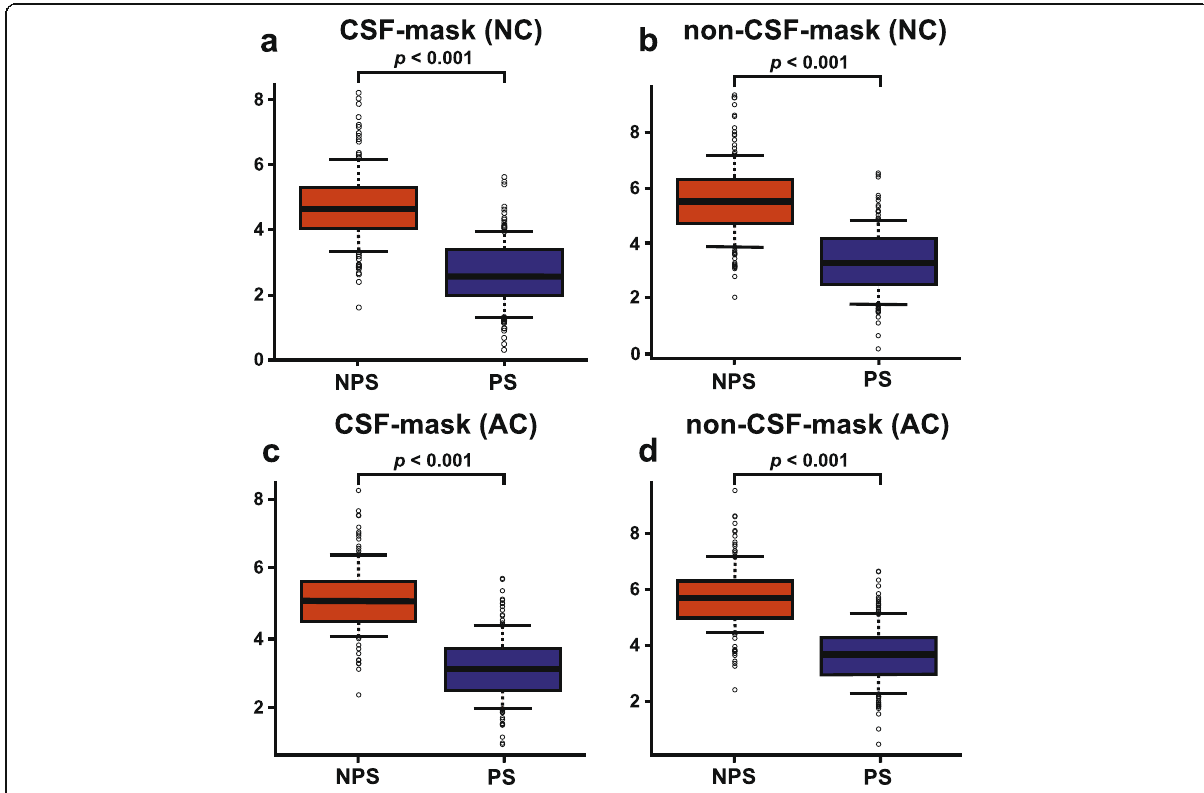
Fig. 3 Box-and-whisker plots of the SBRs with CSF-mask in non-attenuation corrected images ( a ), without CSF-mask in non-attenuation corrected images ( b ), with CSF-mask in attenuation-corrected images ( c ), and without CSF-mask in attenuation-corrected images ( d )